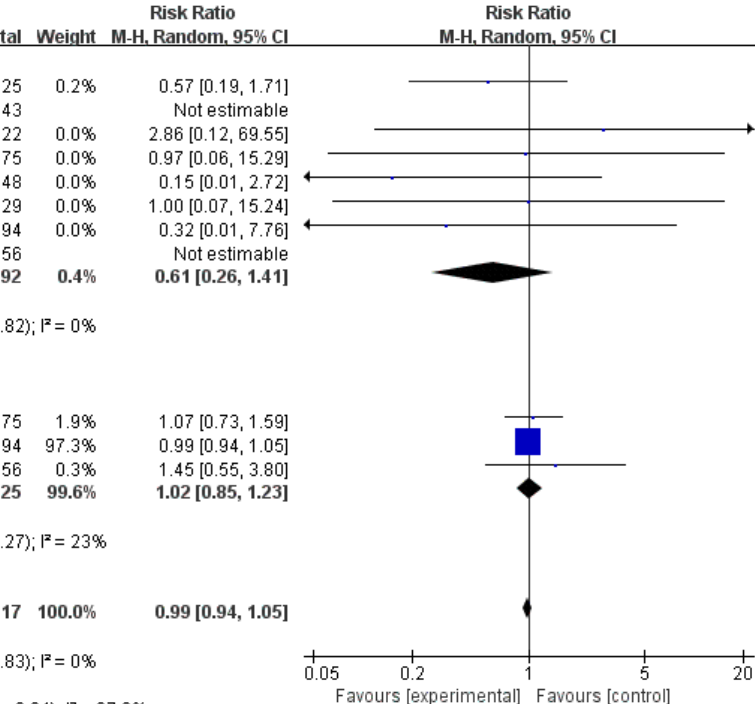
Figure 7. Results of a meta-analysis of the effects of technology-based interventions on mortality and hospitalization events in oral anticoagulation management. M-H: Mantel-Haenszel method. Random: random effect